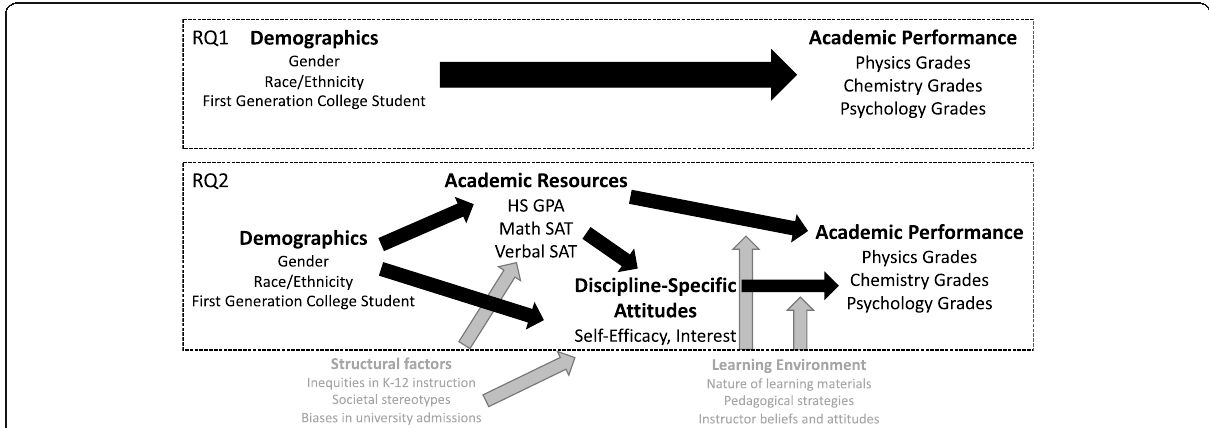
Fig. 1 Theoretical model of how variation in motivational attitudes and academic resources relates to academic performance. Note: This figure shows the observed relationship between demographics and academic performance (RQ1), and the theoretical model of the role of academic resources, discipline-specific motivational attitudes, and academic performance within each discipline (RQ2). Theorized structural causes of (1) demographic differences in academic resources and discipline-specific motivational attitudes, and (2) differences in how resources and attitudes predict grades, are shown in grey. RQ = Research